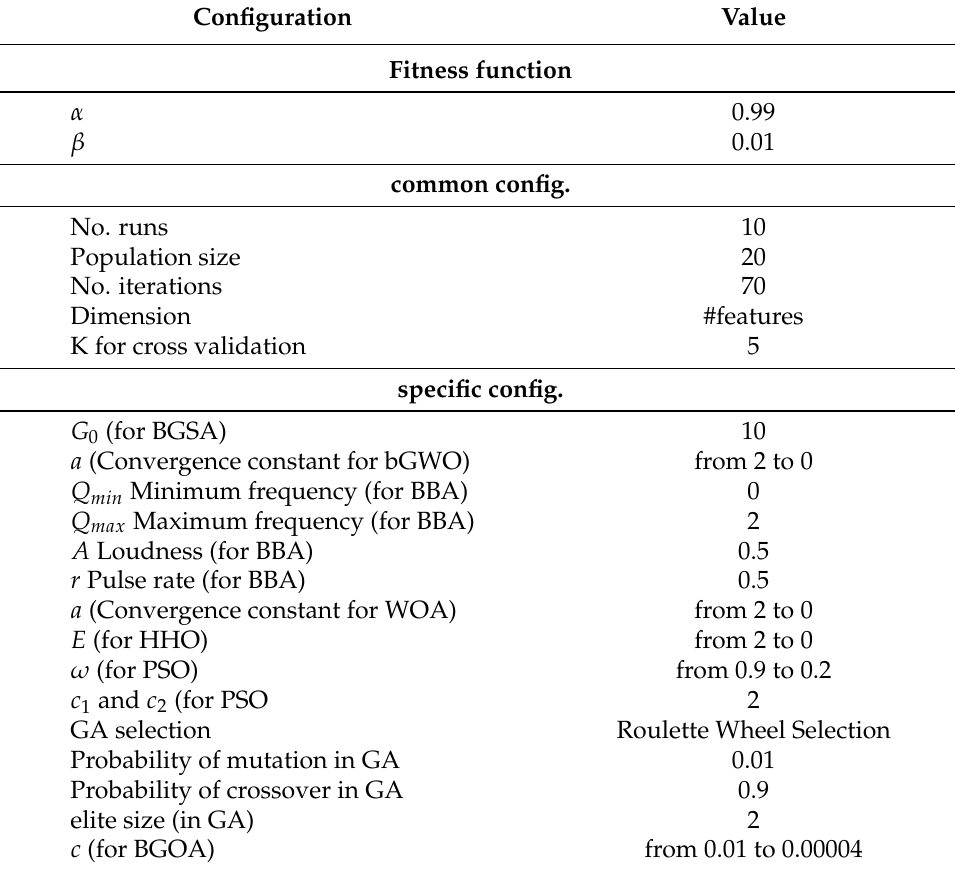
Table 4. The detailed parameters settings.